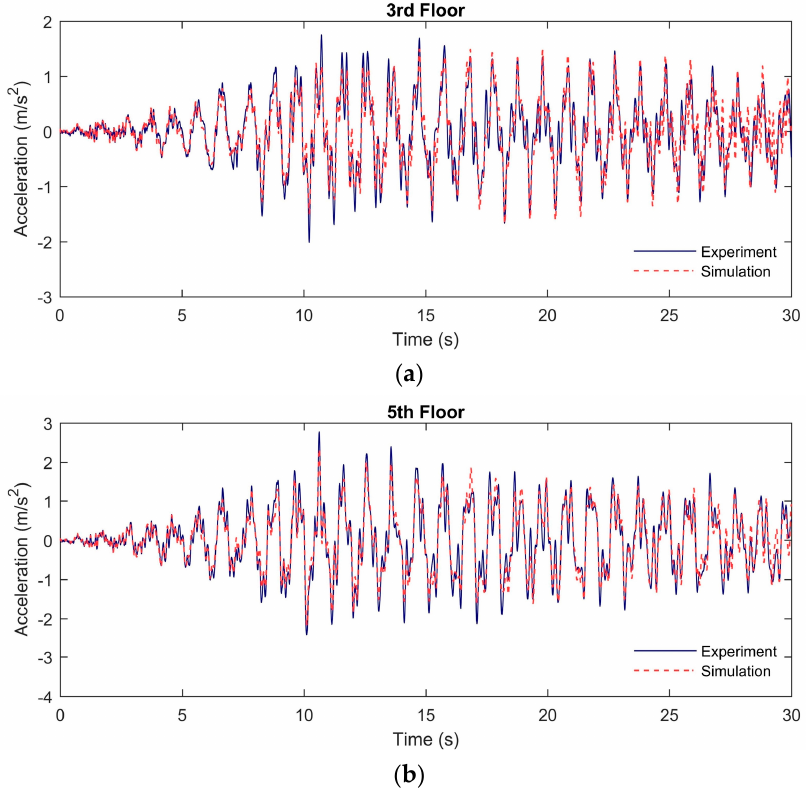
Figure 19. Experimental and simulation acceleration time histories in the nonlinear structural system: ( a ) At the 3rd floor; ( b ) At the 5th floor.